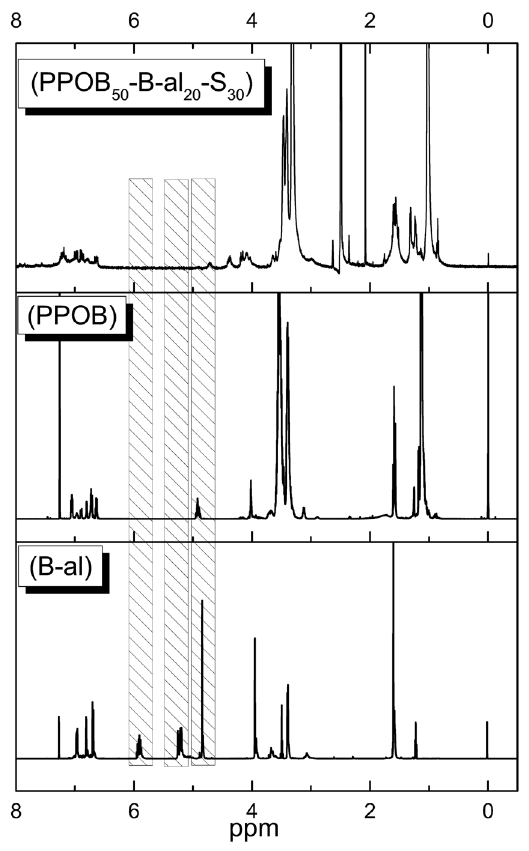
Figure 5. Overlaid 1 H NMR spectra of B-al, PPOB and PPOB 50 -B-al 20 -S 30